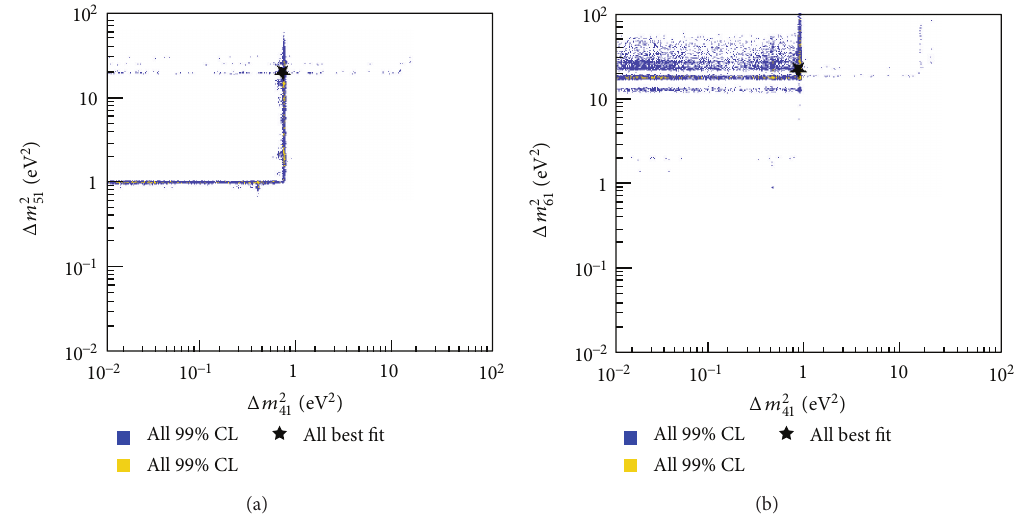
Figure 10: The Δ𝑚 2 51 versus Δ𝑚 2 41 and Δ𝑚 2 61 versus Δ𝑚 2 41 correlations from fits to all data in a ( 3 + 3 ) model.